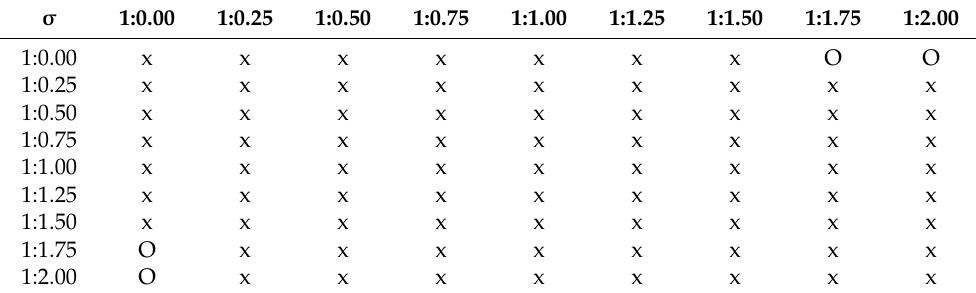
Table A7. Significant difference in conductivity between various Slacker concentrated groups. A significant difference was indicated with O and an insignificant difference was indicated with x.